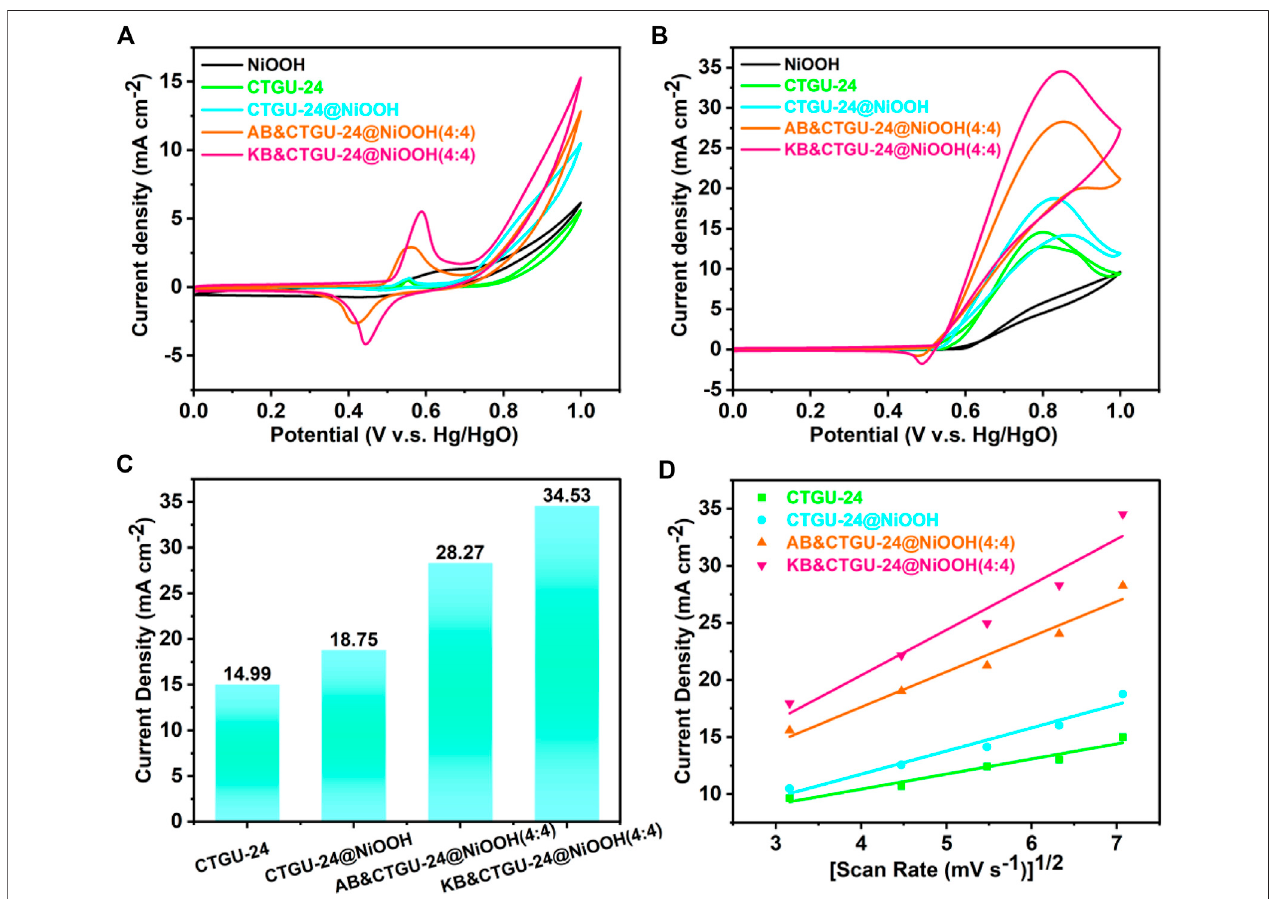
FIGURE 4 | CV curves of four as-synthesized catalysts in 0.1 M KOH in the absence (A) and (B) presence of 1.0 M methanol at a scan rate of 50 mV · s − 1 . (C) Bar graph of the area current density for four samples. (D) View of the linear relationship between the current density and the square root of the scan rate for four catalysts.